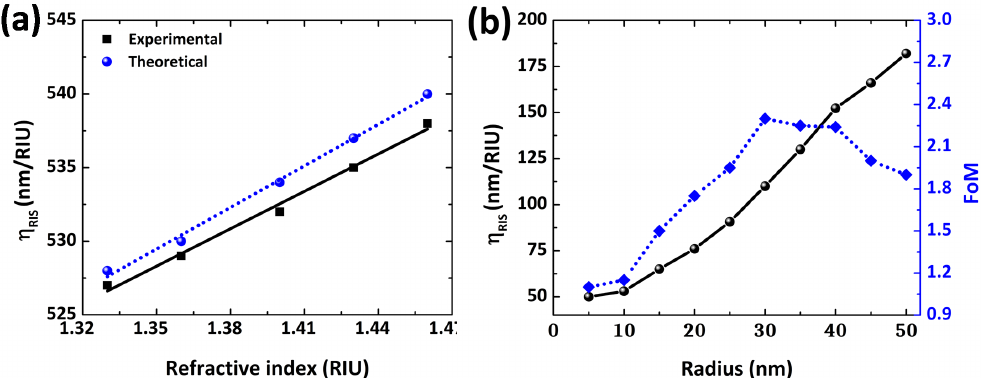
Figure 7. Evaluation of RI-based sensing on changing the surrounding medium ( a ) and η RIS with FoM as a function of NP radius ( b ).